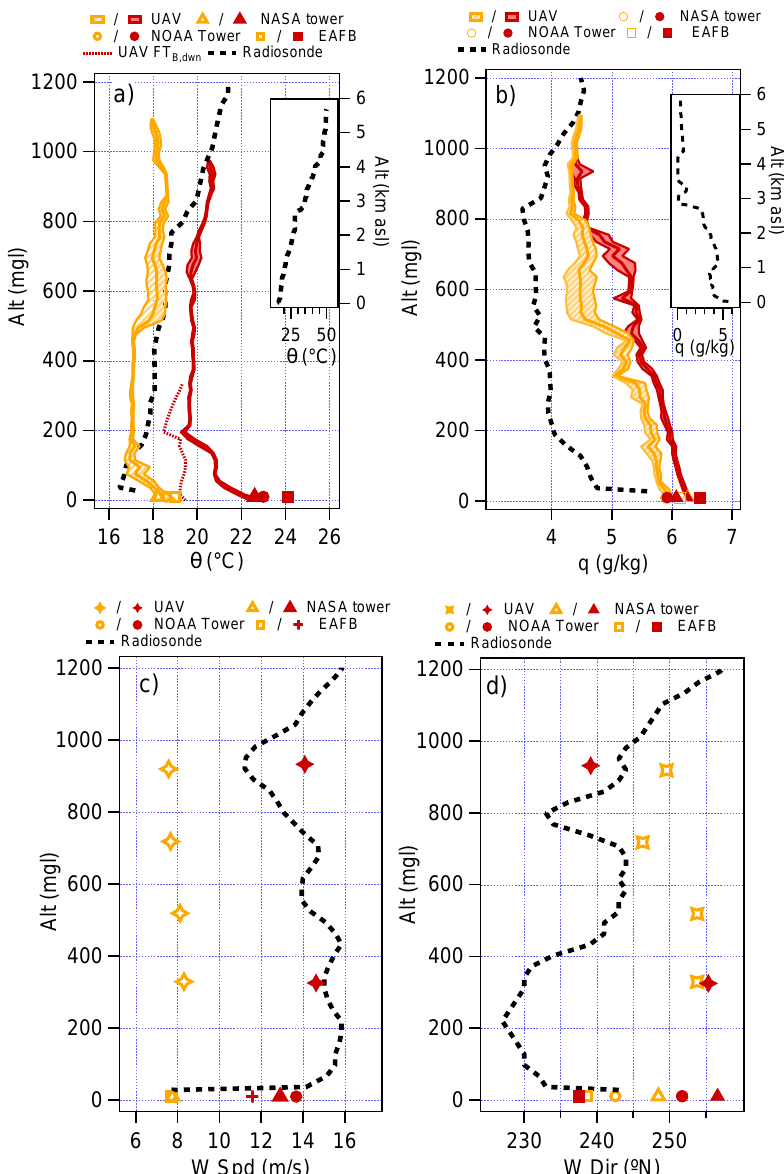
Fig. 9. UAV ascent profile plots averaged over 20m intervals during FT A (open symbols, yellow, 09:13a.m.–11:54a.m.)/FT B (closed symbols, red, 12:48p.m.–02:12p.m.) for (a) potential temperature θ (also shown is the descent profile of FT B ) , and (b) water vapor mixing ratio q ; shaded areas denote 1- σ . Plots (c) and (d) display flux run averages of wind speed and direction. Ground station measurements corresponding to the launch periods are included in each plot as well as EAFB 03:00a.m. (1100 z ) radiosonde data. Inset plots are of radiosonde (a) derived θ and (b) q for up to 6km